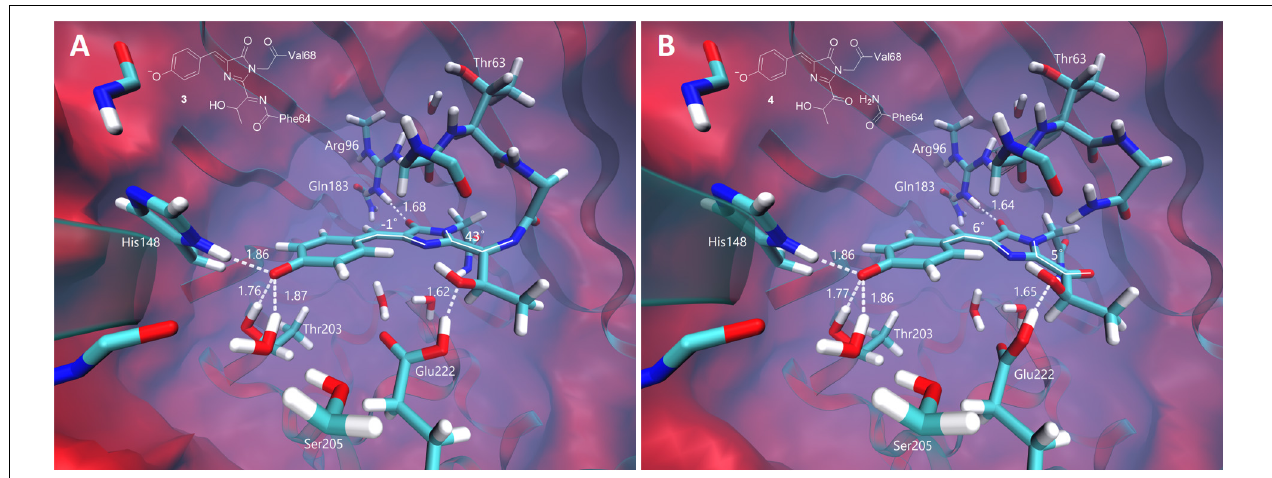
FIGURE 6 | Ground-state equilibrium structures of the red-emitting forms. (A) The non-hydrolyzed DsRed-like chromophore. (B) The hydrolyzed asFP595-like chromophore. Only the QM parts are shown for clarity. All distances are shown in Å.